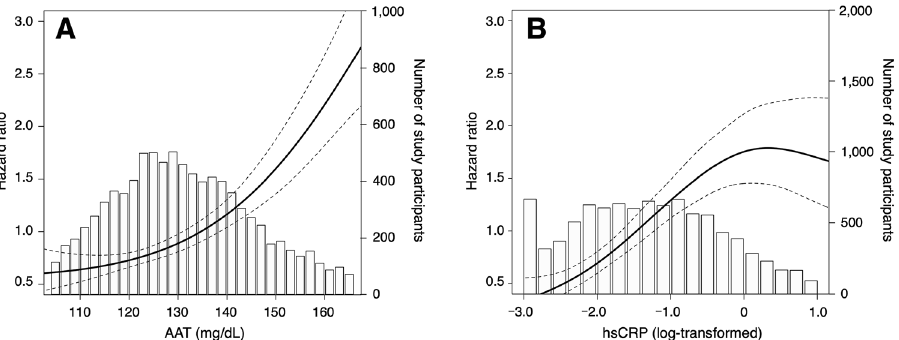
Figure 1. Penalized cubic splines of the association between baseline AAT and hsCRP levels and the hazard ratio for all-cause mortality. Lines indicate the hazard ratio and 95% confidence interval (CI) of baseline.